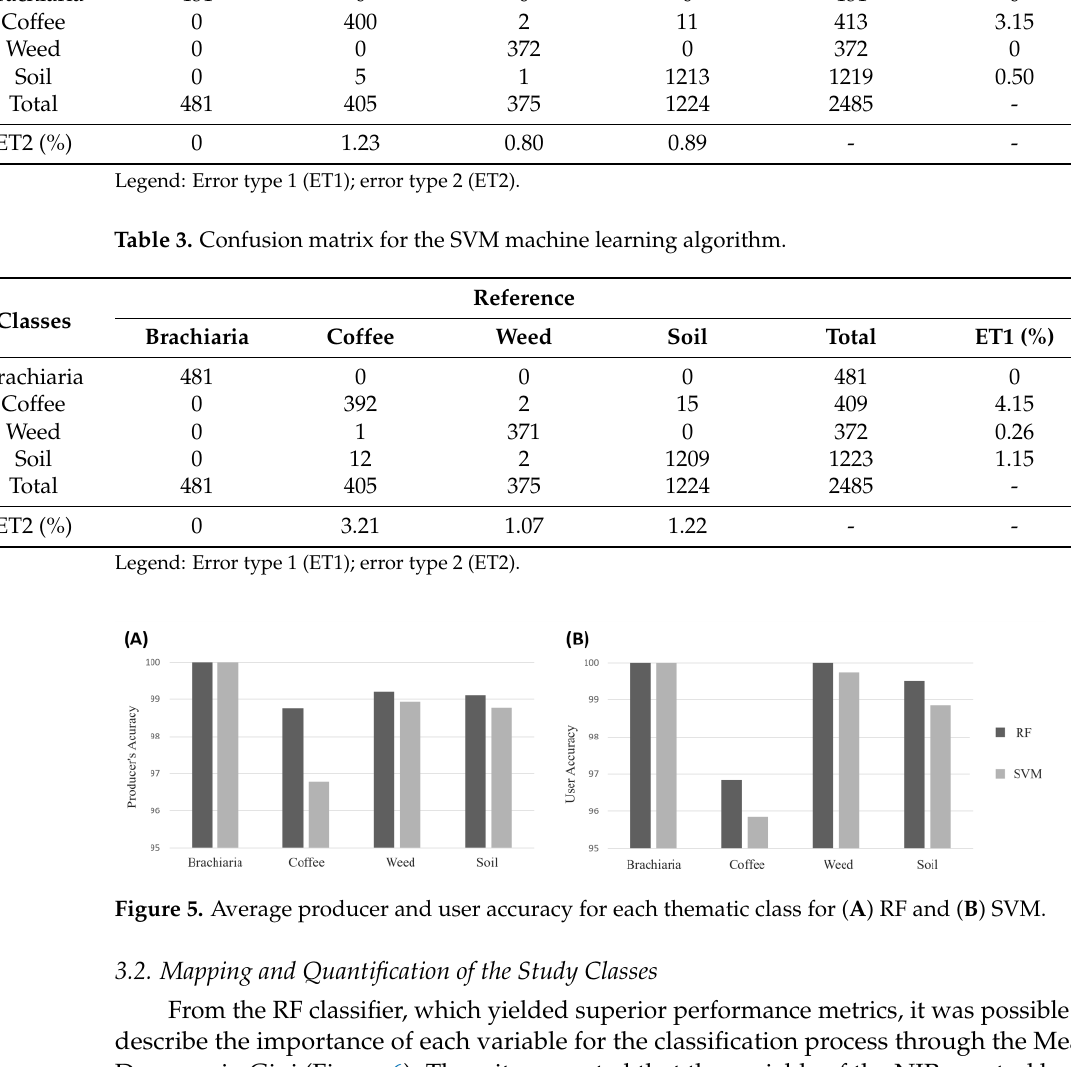
Table 3. Confusion matrix for the SVM machine learning algorithm.